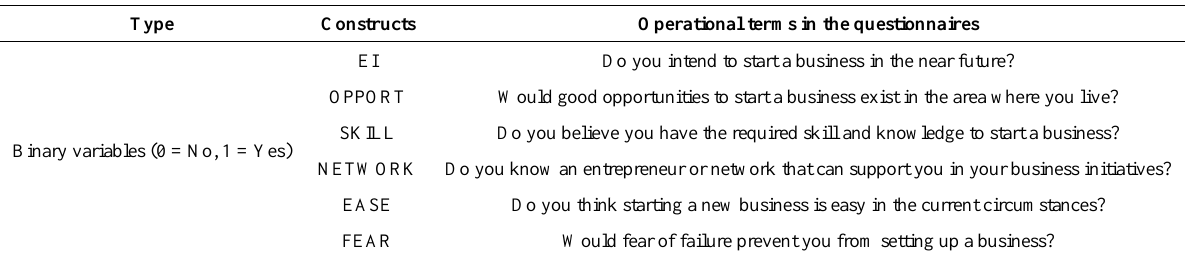
Table 1. Questionnaire Constructs and